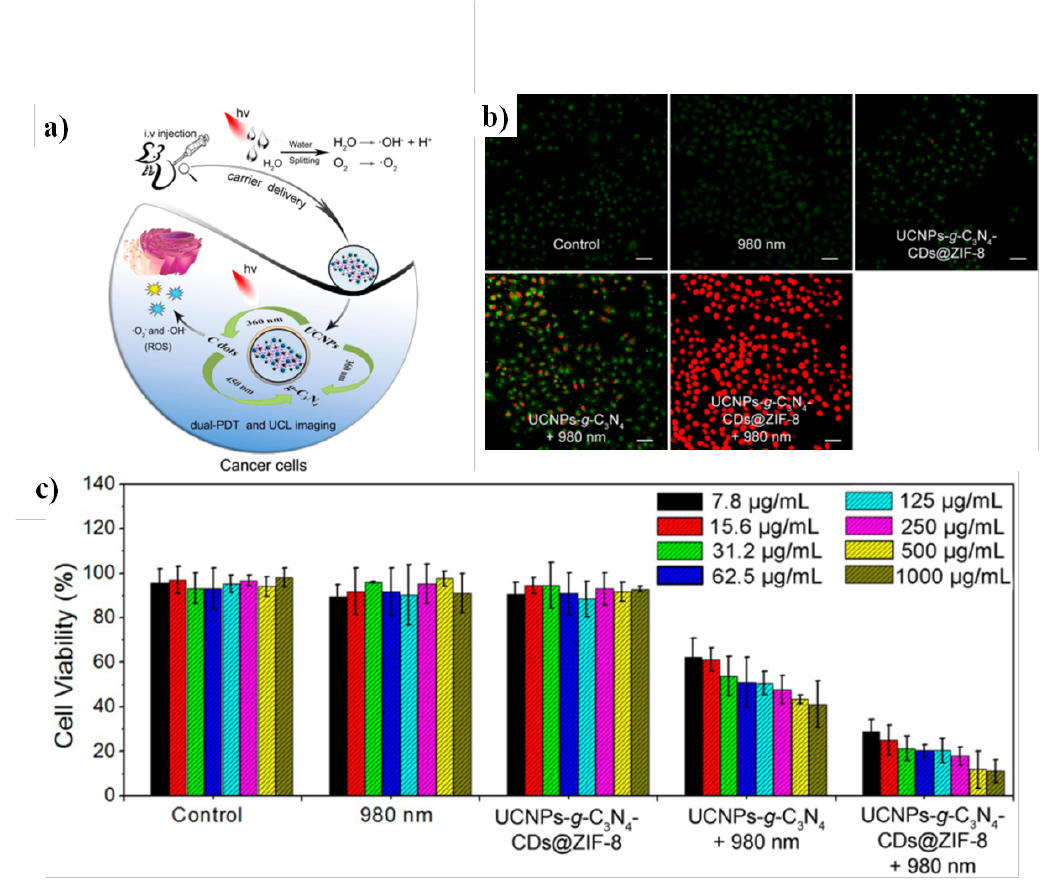
Figure 14: a) Reaction mechanism diagram. b) CLSM images of HeLa cells incubated with different conditions corresponding to the toxicity test in vitro, and all the cells are marked with calcein AM and PI. Scale bars for all images are 50 µ m. c) In vitro cell viabilities of HeLa cells incubated with cellculture (control), 980nm light, UCNPs-g-C 3 N 4 with 980nm laser irradiation and UCNPs-g-C 3 N 4 -CDs@ ZIF-8 at varied concentrations with and without 98 nm laser irradiation